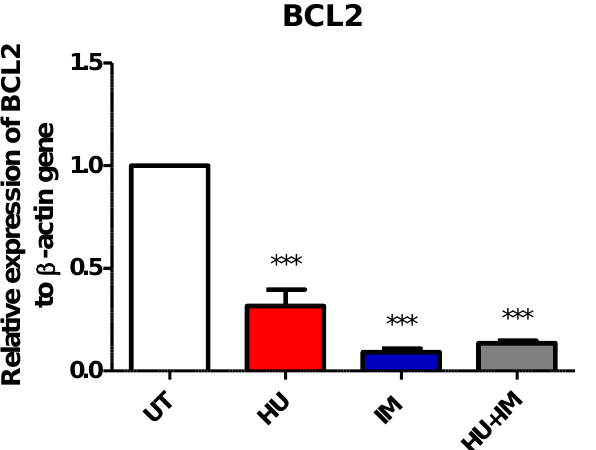
Figure 2. The relative expression of BCL2 gene to β -actin gene. Two-tailed paired t -test revealed a significant statistical difference between UT vs. HU, UT vs. IM and UT vs. HU + IM (*** p < 0.005). (mean ± SEM; n = 2).